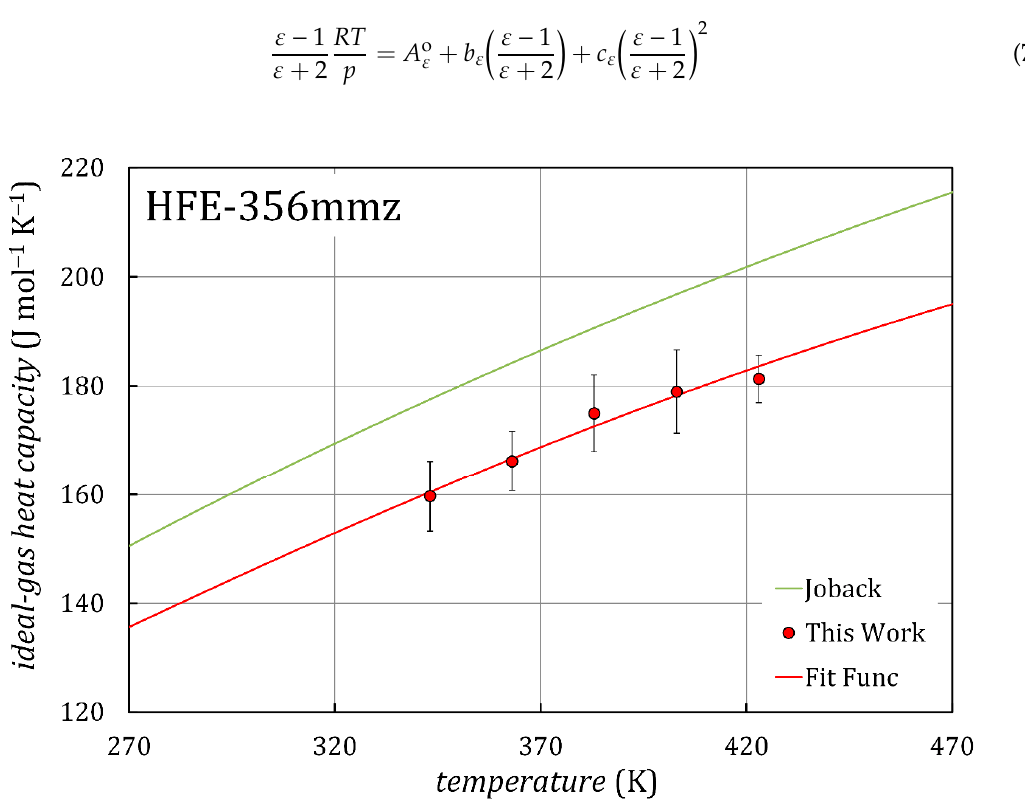
Energies 2020 , 12 , x Figure 3. Temperature dependence of the ideal-gas heat capacity data for HFE-356mmz. Table 3. Sound velocity data in the vapor phase for HFE-356mmz.